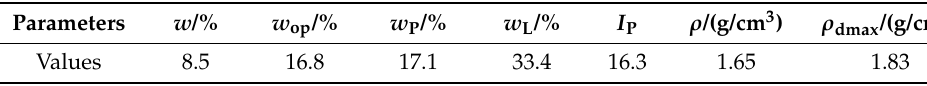
Table 1. Physical characteristics of red clay.